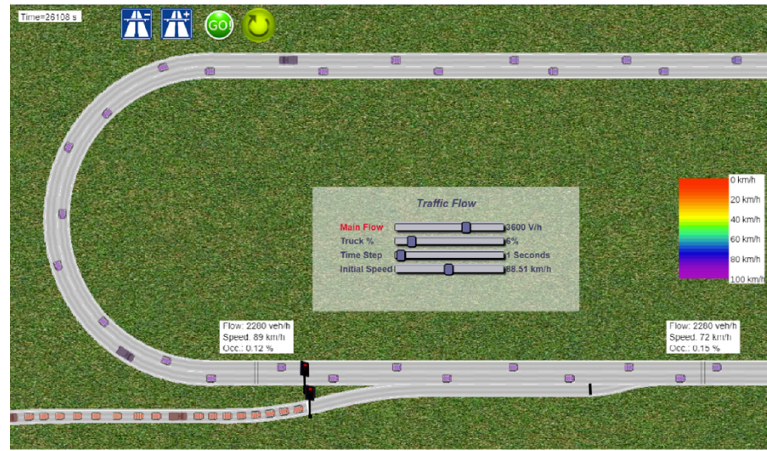
Figure 9. The ramp metering scenario simulated in MovSim.